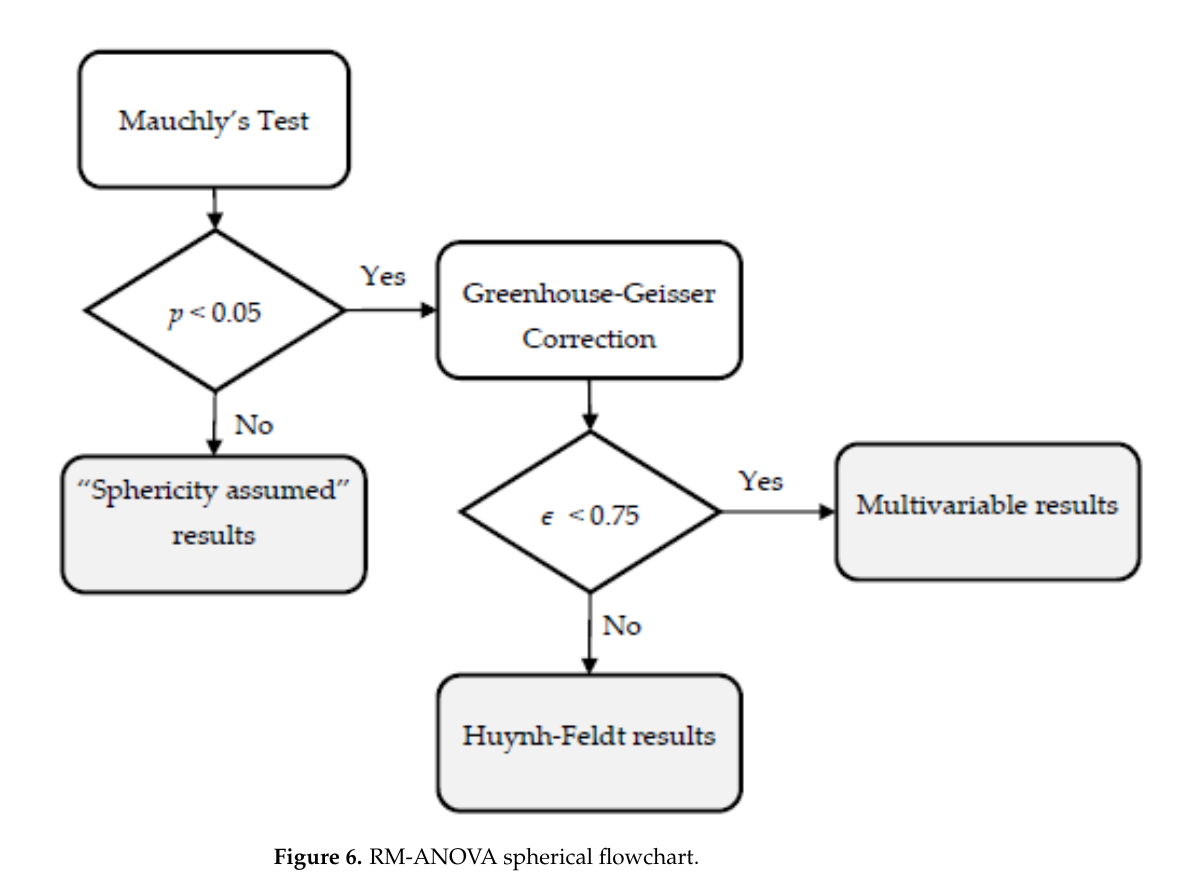
Figure 6. RM-ANOVA spherical flowchart.